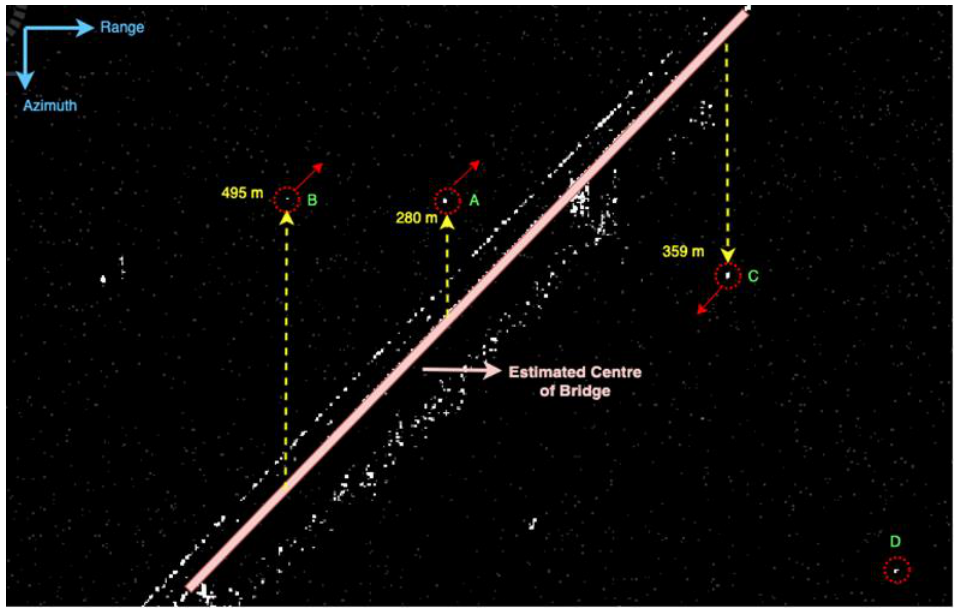
Figure 9. Detected vehicles with motion direction (red arrows) and azimuth distance (yellow arrows) from bridge 6 on 13 July 2016. Vehicle speeds are listed in Table 2. COSMO-SkyMed ® Product © ASI—Italian Space Agency—2016. All Rights Reserved. Table 2. Velocity of three detected moving vehicles at Baishazhou Bridge on 13 July 2016. Refer to Figure 9 for